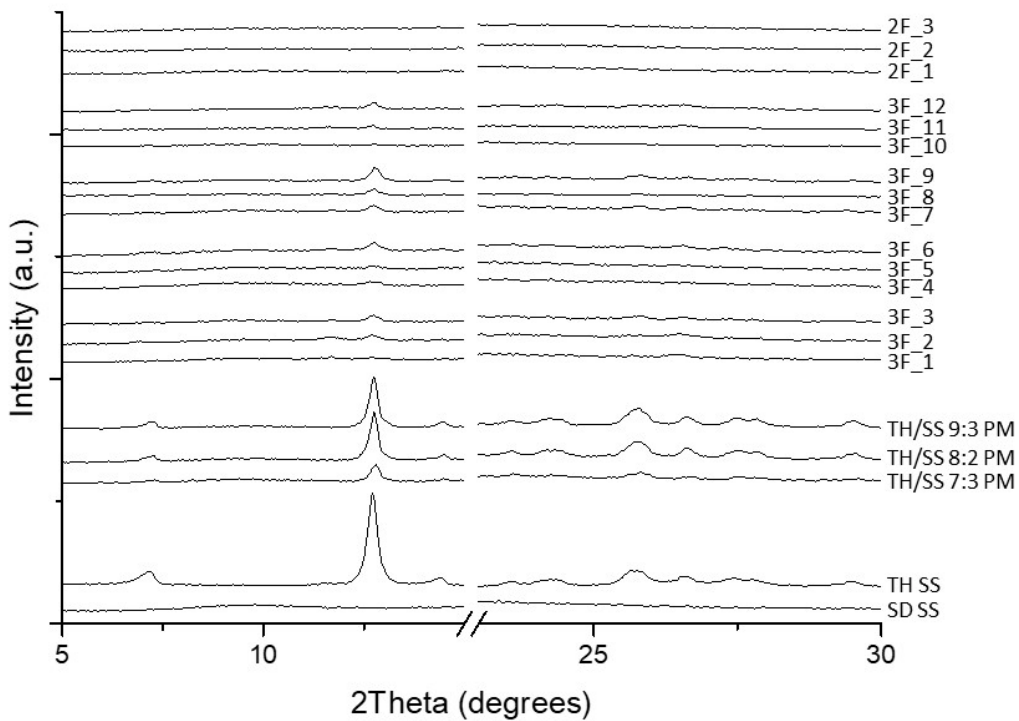
Figure 3. Powder X-ray Di ff raction (PXRD) patterns of spray-dried samples and physical